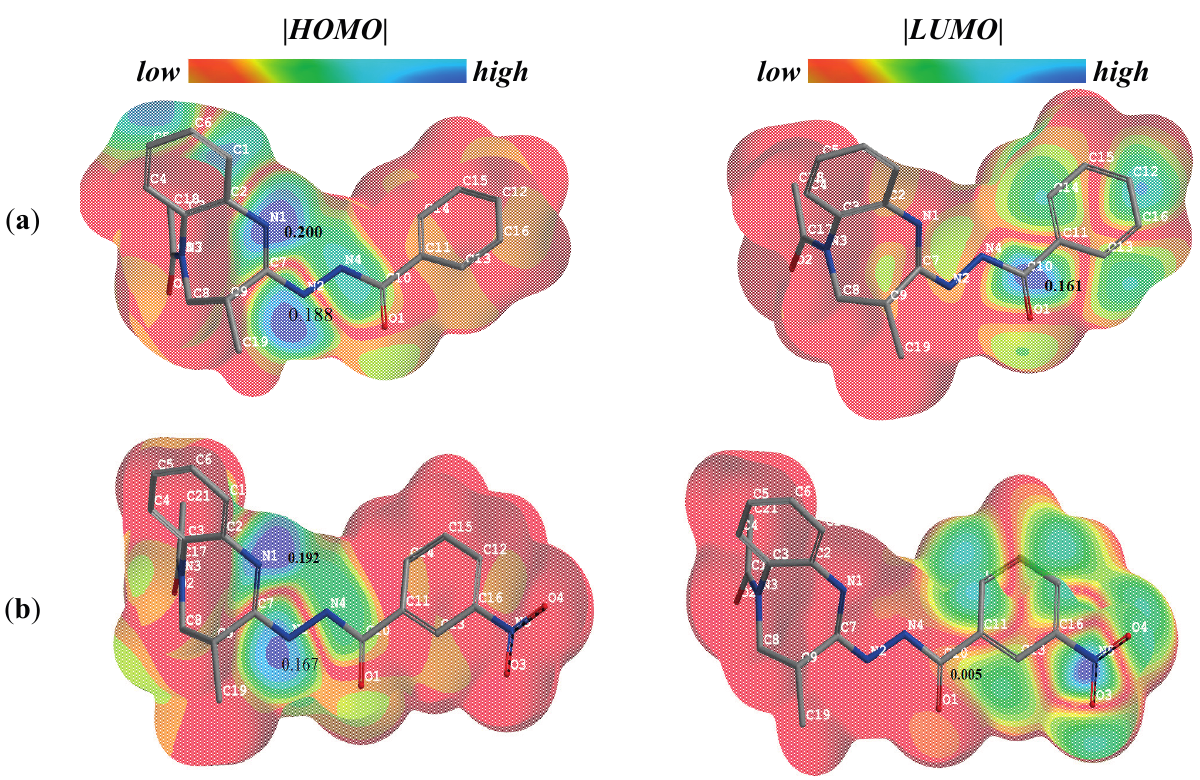
Figure 2. ( a ) The | HOMO | and | LUMO | maps of N’-(1-acetyl-2-methyl-2,3-dihydro-1H-1,5- benzodiazepin-4-yl)benzohydrazide and their highest nucleophilic ( F − k ) and electrophilic ( F + k ) Fukui function values; ( b ) | HOMO | and | LUMO | maps of N'-(1-acetyl-2-methyl-2,3- dihydro-1 H -1,5-benzodiazepin-4-yl)-3-nitrobenzohydrazide and their highest F − k and F + k values. | HOMO | and | LUMO | izo-values =